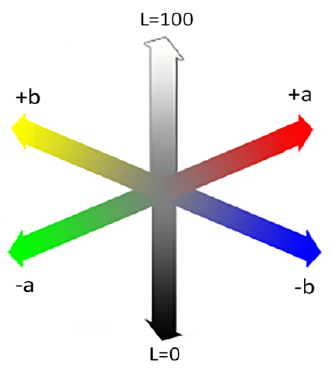
Figure 2. CIE L*a*b* color system.